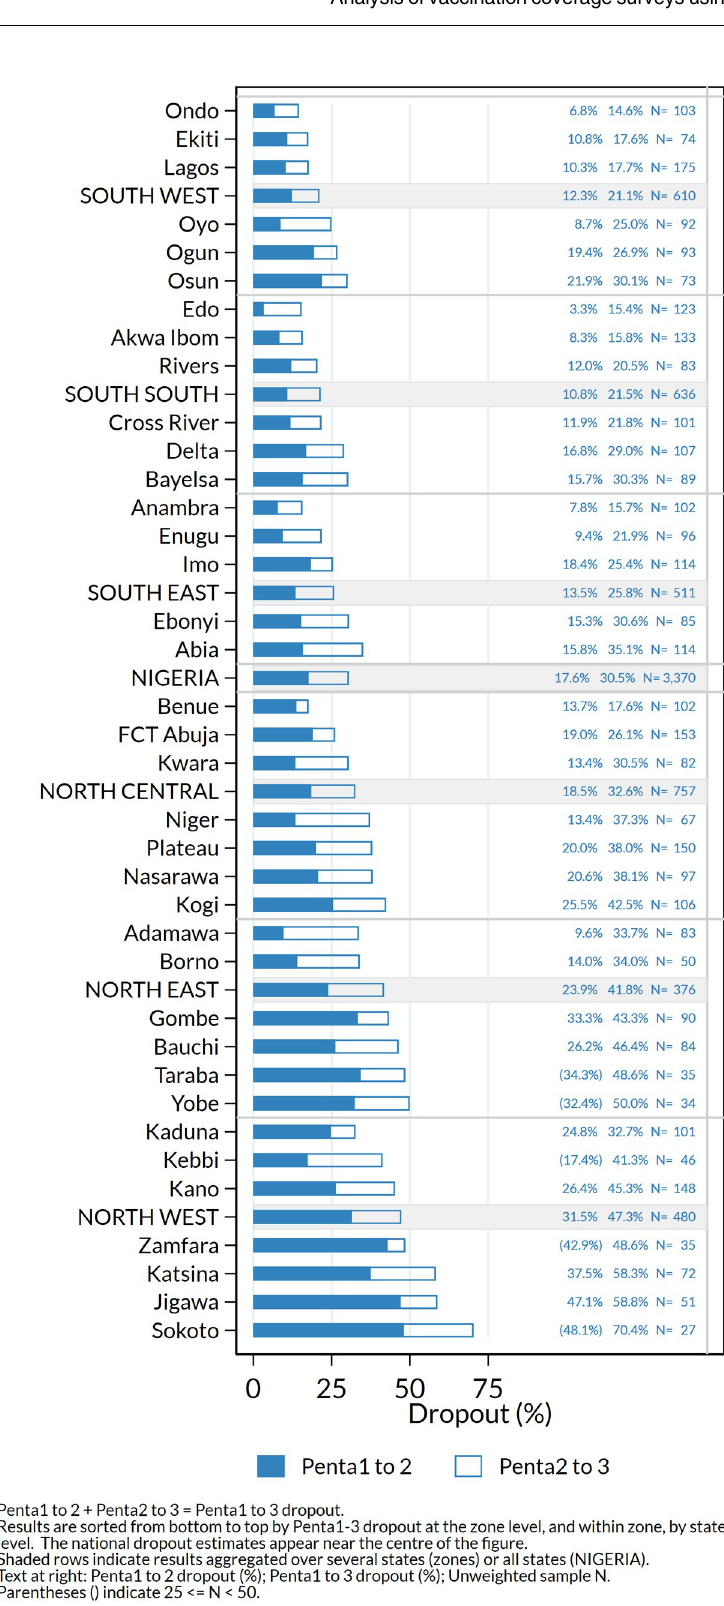
Fig 6. Percentage dropout according to HBR or recall between first and second doses (Penta1-2) and between first and third doses (Penta1-3) of pentavalent vaccine among children who received Penta1, by state, Nigeria MICS/ NICS